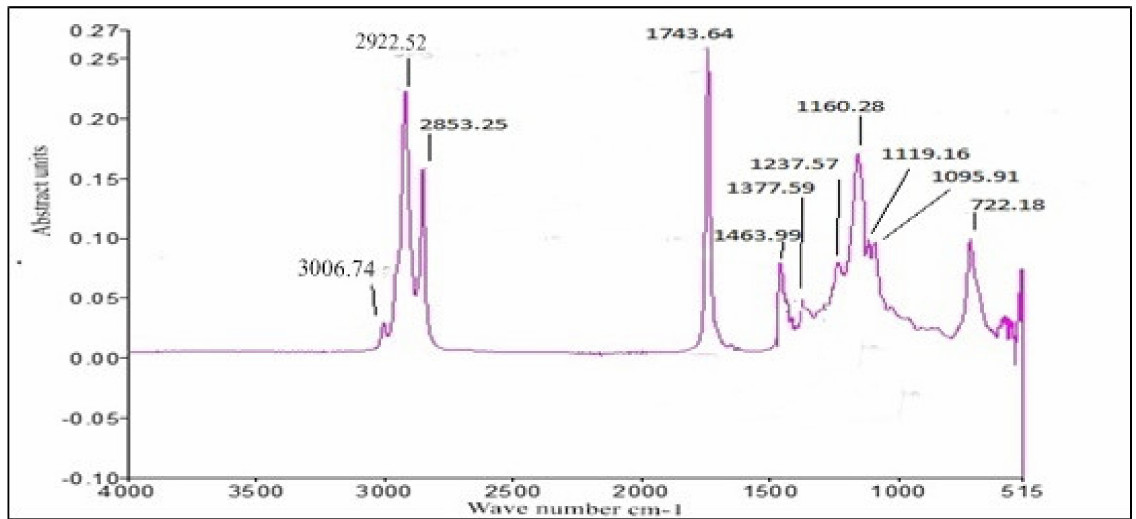
Figure 17. FT-IR analysis of Prunus aitchisonii oil biodiesels by using TiO 2